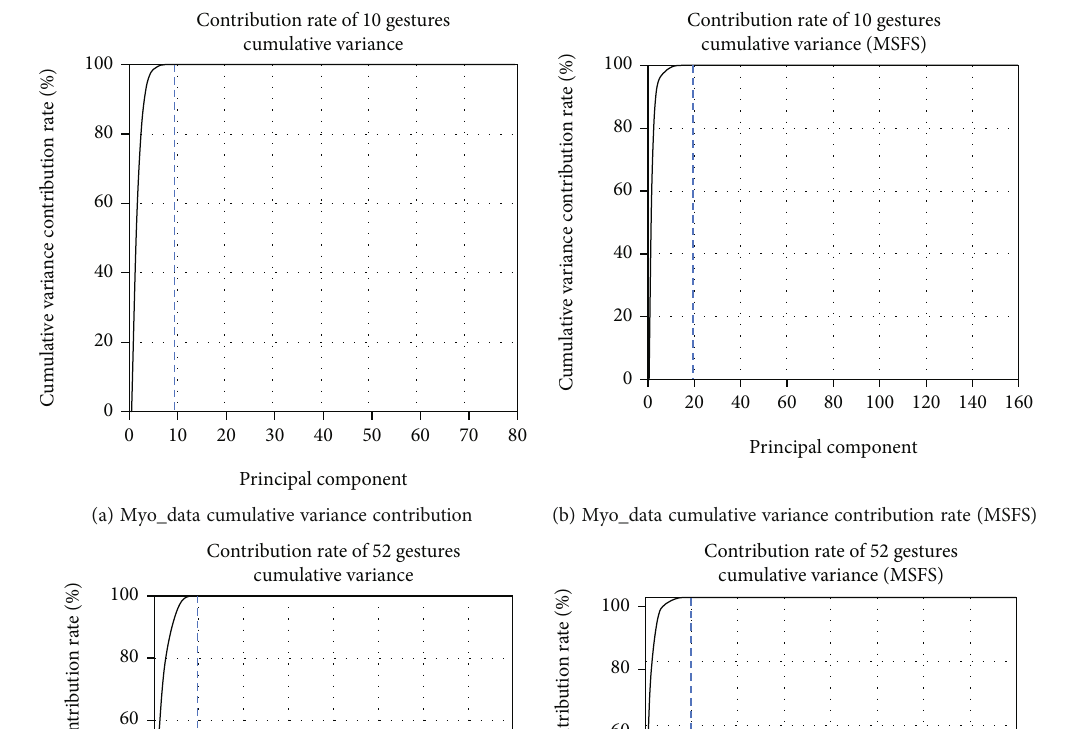
Figure 8: The TCND architecture.